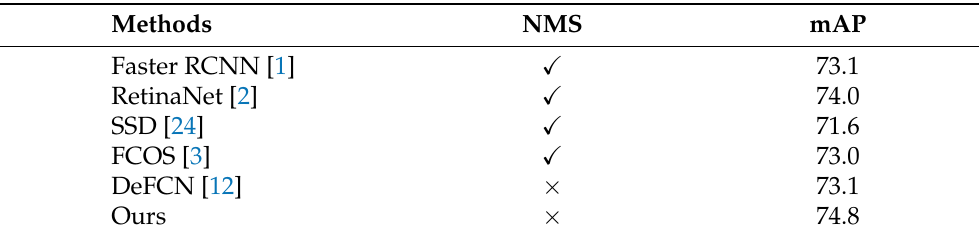
Table 2. Performance comparisons with the state-of-the-art object detectors on PASCAL VOC2007 test set. ’NMS’ column indicates whether the method uses NMS.